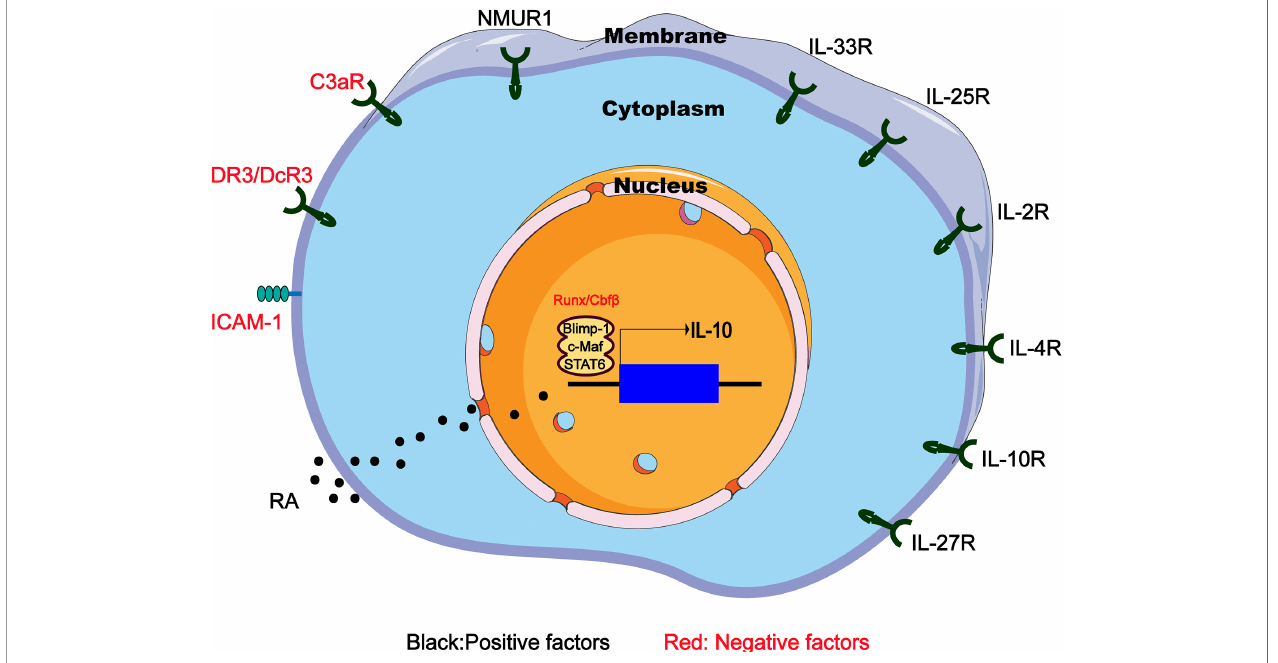
FIGURE 2 | Regulators of IL-10 expression in IL-10-producing ILC2s. IL-10-producing ILC2s can be induced and regulated through different mechanisms including extracellular chemical factors, cytokine and membrane proteins that trigger signaling and transcription factors in the nucleus. RA, retinoic acid; NMUR1, neuromedin U receptor 1; DR3/DcR3, death receptor 3 and decoy receptor 3; ICAM-1, intercellular adhesion